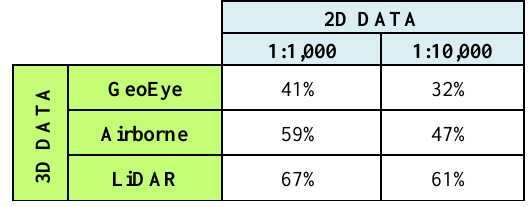
Table 1. Percentage of correctly reconstructed building in the test